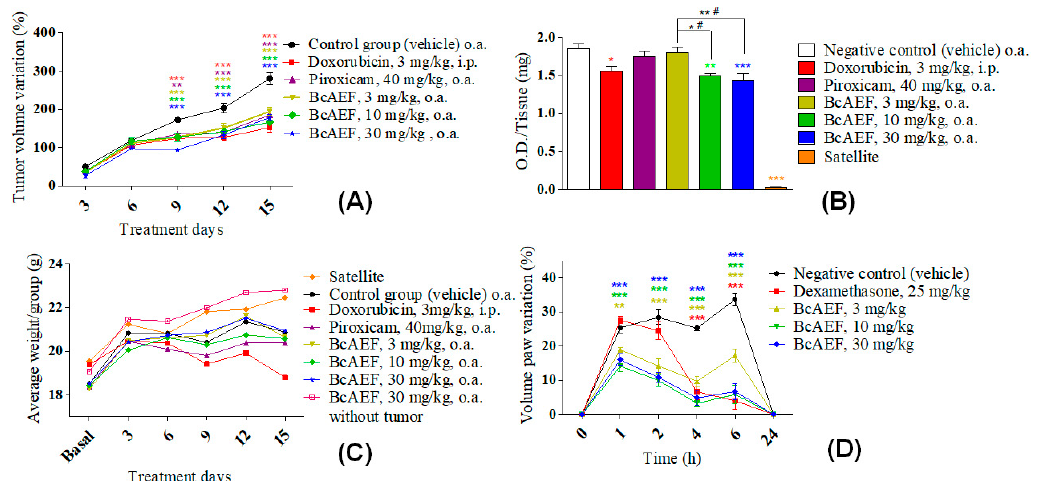
Figure 5. Antitumor and anti-inflammatory e ff ects of BcAEF on Ehrlich solid tumor model and CG-induced paw edema model. ( A ) Mean tumor volume variation (%) in the Ehrlich solid tumor paw model during 15 days of treatment with vehicle (negative control), positive controls, and BcAEF. ( B ) Myeloperoxidase (MPO) activity expressed as O.D (optical density) per milligram of paw tissue with (vehicle group, positive controls and BcAEF) or without (satellite group) Ehrlich’s solid tumor. ( C ) Variation of mice body weight during 15 days of experiment of Ehrlich’s solid tumor in the paw. ( D ) CG-induced paw edema represented by edema variation (%). Results were expressed as mean ± standard error . Groups = vehicle (negative control), doxorubicin (positive control), piroxicam (positive control), BcAEF (3, 10, and 30 mg / kg), satellite (without inoculation of tumor cells and without treatment) and a group treated with the higher dose of BcAEF (30 mg / kg), in which tumor cells were not inoculated. Legend: i.p. intraperitoneal; o.a. oral administration. Statistical analysis: * p < 0.05, ** p < 0.01 and *** p < 0.001, statistically significant di ff erence in relation to the vehicle group